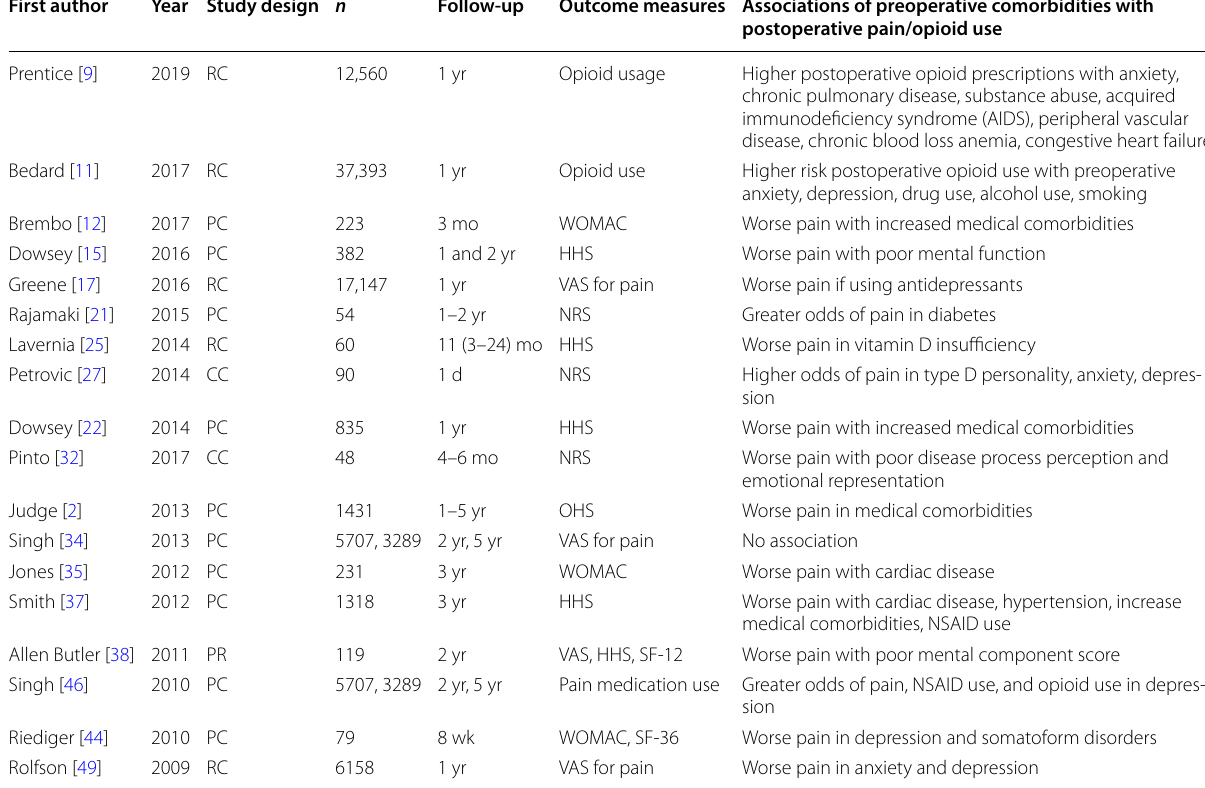
ASA American Society of Anesthesiologists, CAD Coronary artery disease, CC Case–control, CCI Charlson Comorbidity Index, CI Confidence interval, HHS Harris Hip Score, HTN Hypertension, NRS Numerical rating scale, NSAID Nonsteroidal anti-inflammatory drug, OHS Oxford Hip Score, OR Odds ratio, PC Prospective cohort, PR Prospective randomized, RC Retrospective cohort, SF-12 12-Item Short-Form Health Survey, SF-36 36-Item Short-Form Health Survey, VAS 10-cm visual analog scale, WOMAC Western Ontario and McMaster Universities Arthritis